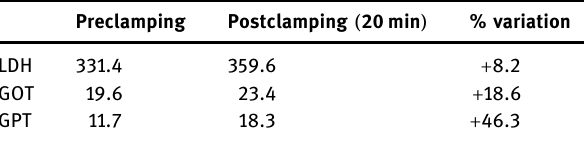
Table 1: Intraoperative blood enzymes